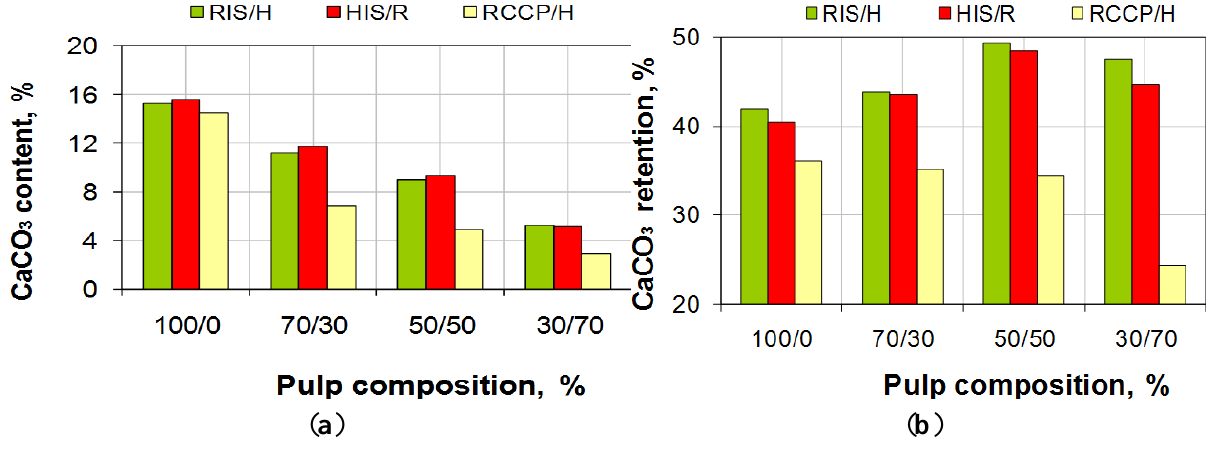
; ( b ) in relation with pulp 3